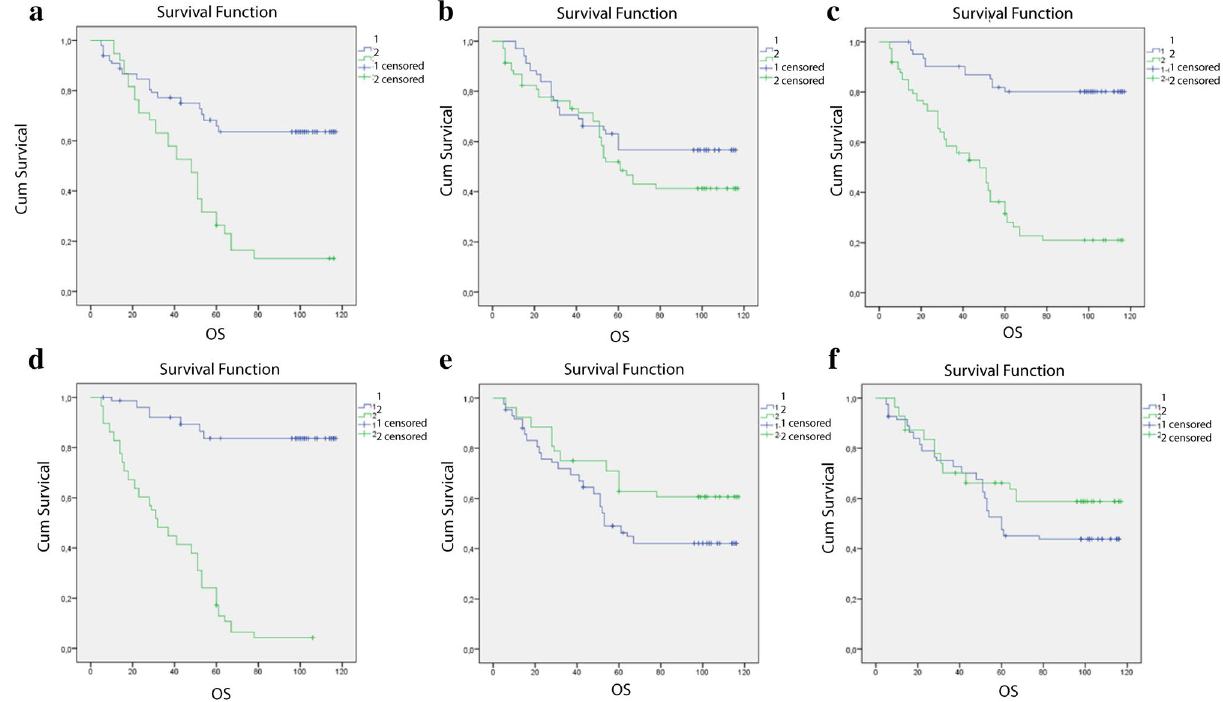
Figure 3. Kaplan–Meier’s overall survival (OS) curve relative to different indicators. ( a ) degree of differentiation: well differentiated cancer (blue line); poorly differentiated cancer (green line). ( b ) age groups: ≤ 62 (blue line); > 62 (green line). ( c ) expression of IMP 3: IMP 3 negative expression (blue line); IMP 3 positive expression (green line). ( d ) vascular invasion: no vascular invasion (blue line); vascular invasion present (green line). ( e ) gender: female (green line); men (blue line). ( f ) tumor size: ≤ 5 cm (green line); > 5 cm (blue line).